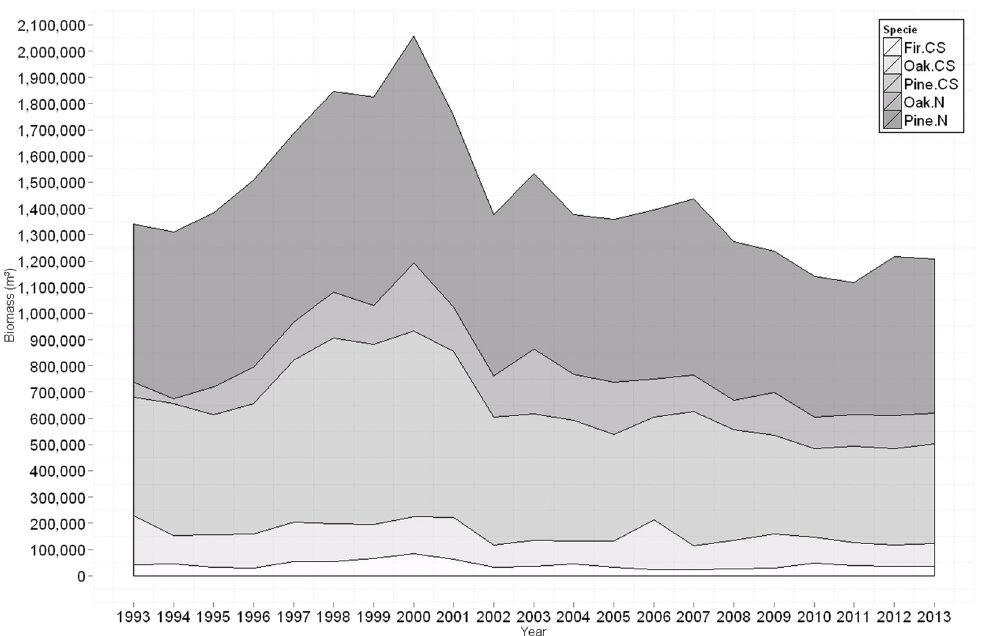
Figure 1. Theoretically available biomass residues (m 3 ) from harvesting for north and central-south regions by species (1993–2013).